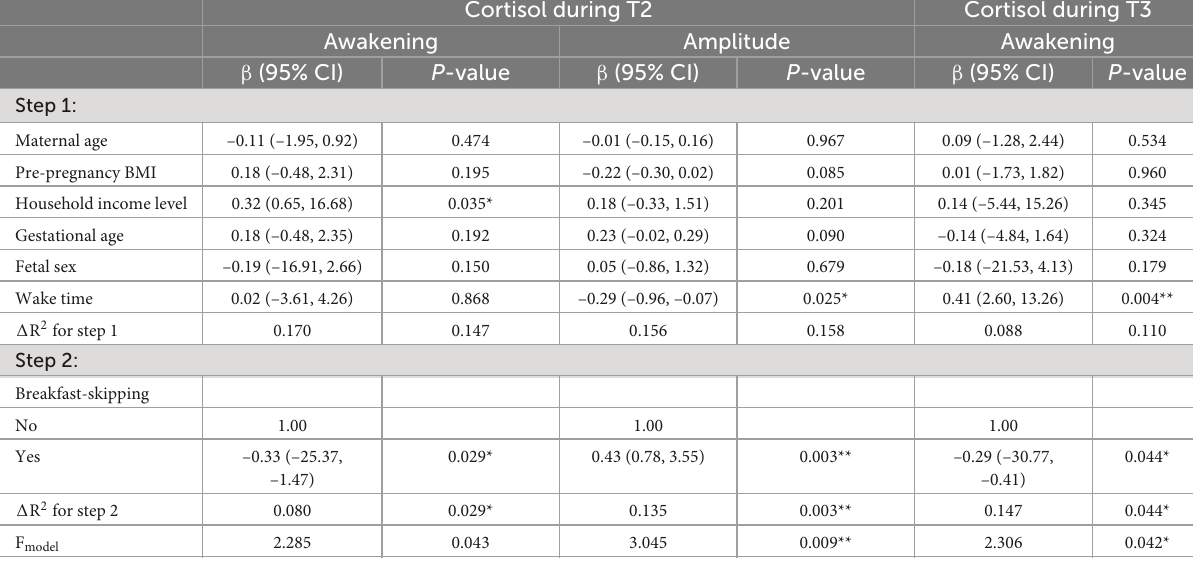
TABLE 4 Hierarchical linear regression models predicting maternal cortisol parameters from chrononutrition characteristics (T2: n = 64; T3: n = 60).